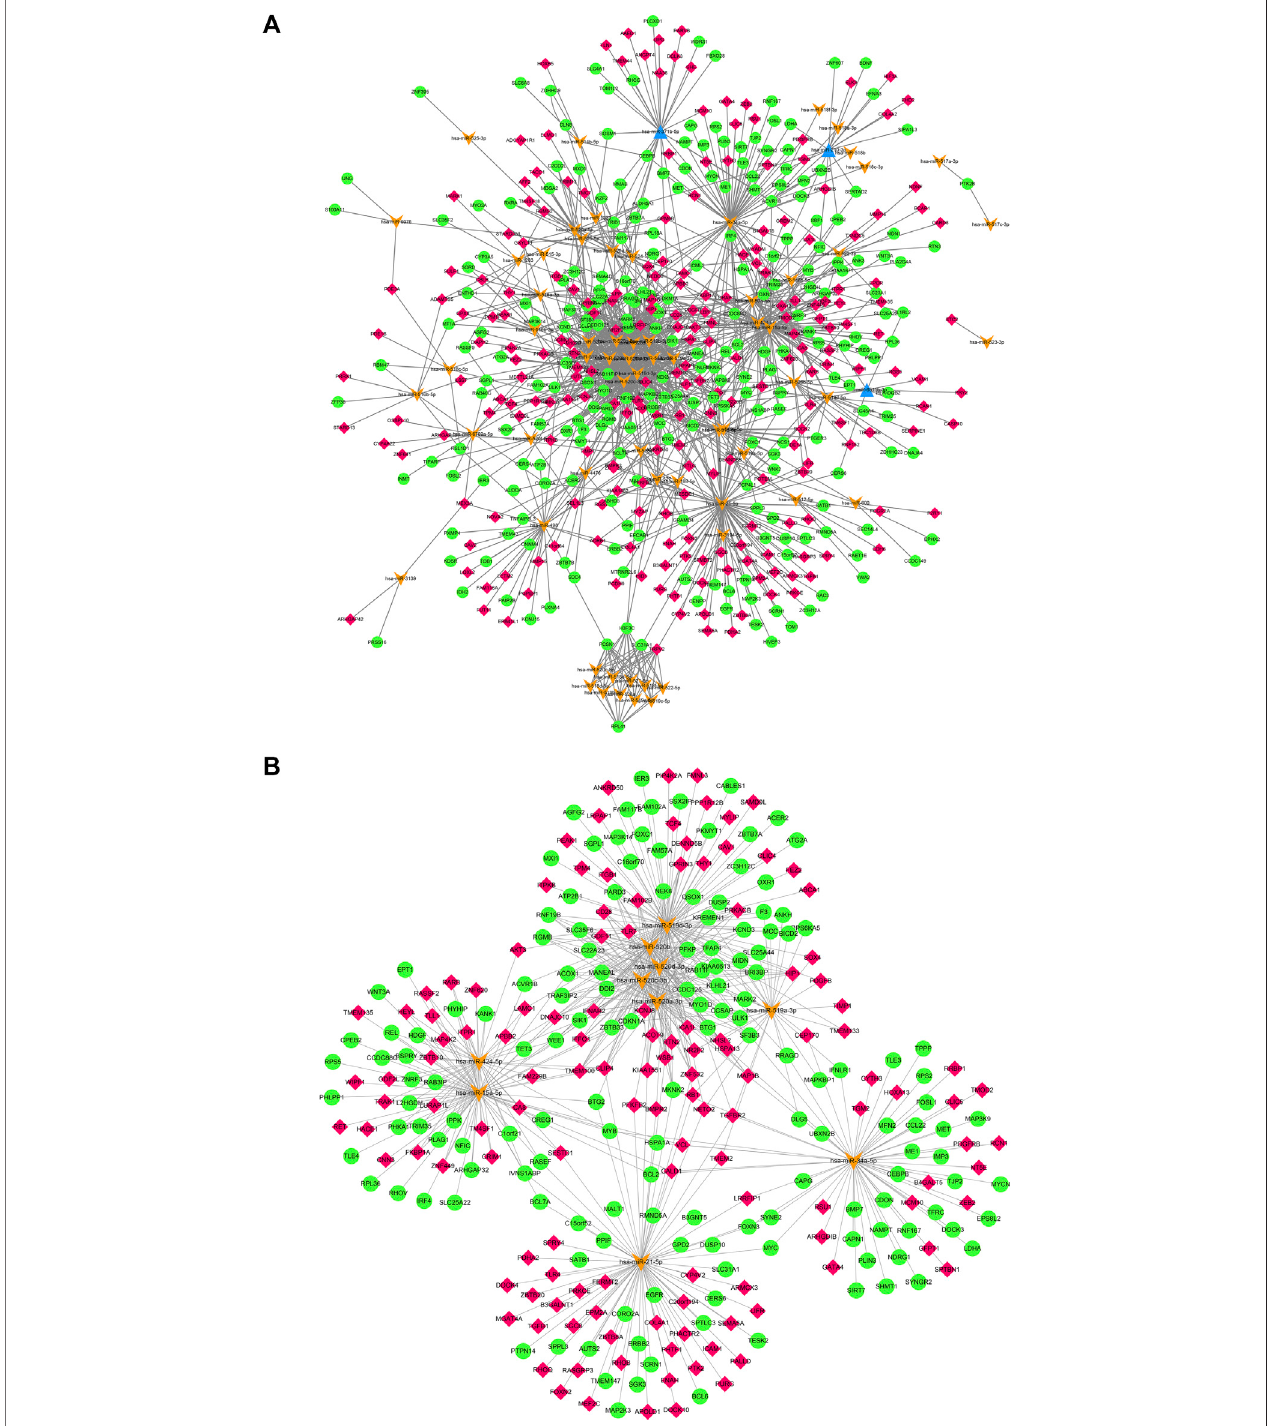
FIGURE 2 | (A) . Regulatory network of DEMs and their target DEGs of IH depicted by cytoscape. (B) . hub DEM-DEG network of IH. Orange arrows mean up-regulated DEMs, blue triangles mean down-regulated DEMs, red rhombus mean up-regulated DEGs, green cycles mean down-regulated DEGs.